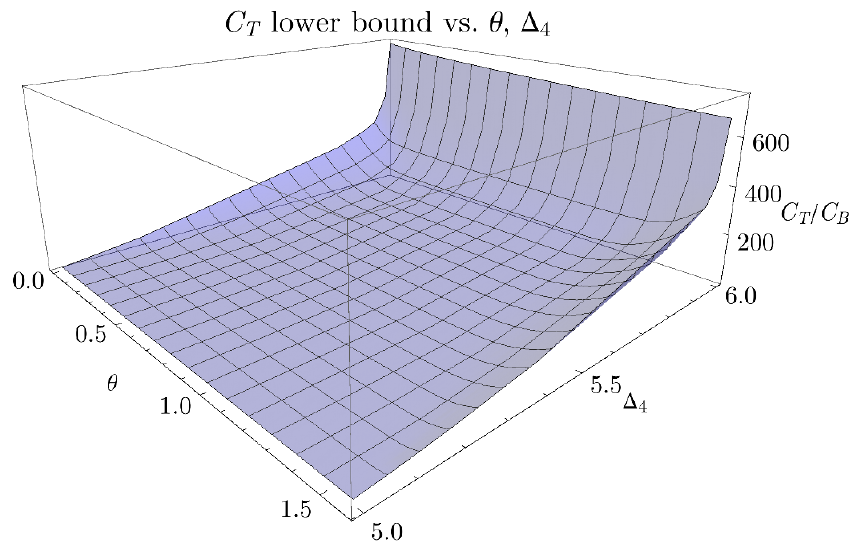
Figure 12 . Lower bounds on C T as a function of (cid:18) and the spin-4 gap (cid:1) 4